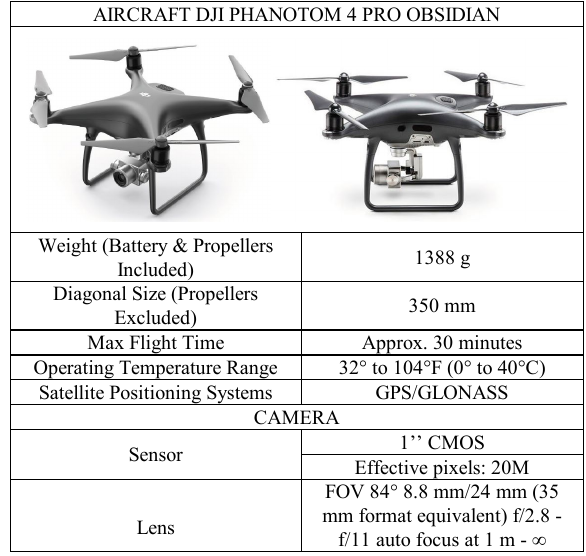
Table 1. Phantom 4 PRO Obsidian main